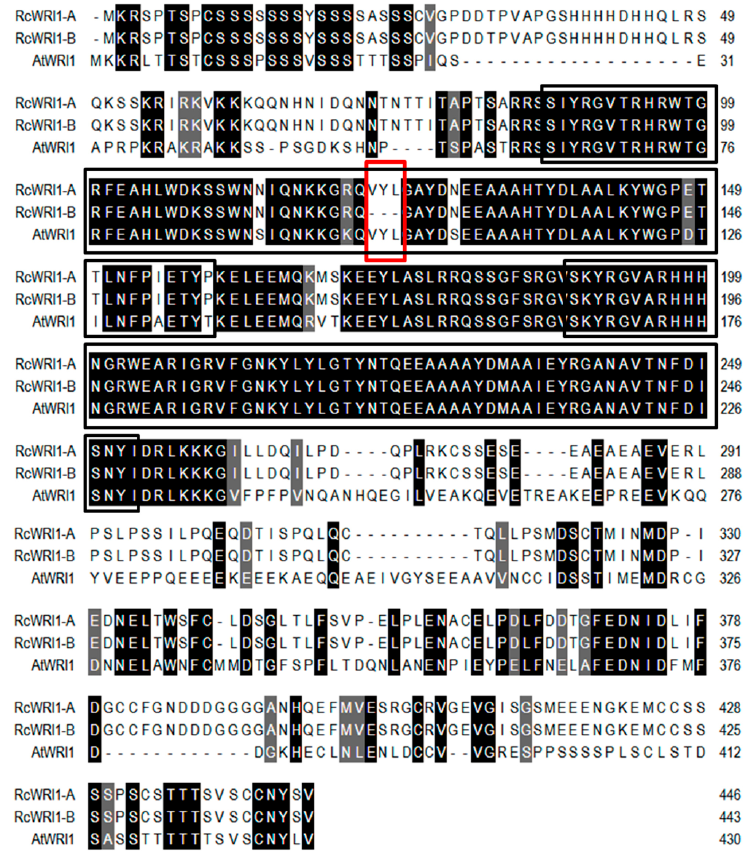
Figure 1. Sequence alignment of two RcWRI1 and AtWRI1 protein isoforms. The alignment was performed by the ClustalW program. Most of the difference between protein sequences of RcWRI1s and AtWRI1 occurs at the C-terminal half of the protein. “VYL” motif in AtWRI1 and RcWRI1-A is absent in RcWRI1-B. The high and low consensus amino acid residues are denoted by black and gray colors, respectively. Two AP2 domains are marked by black boxes. The sequence “VYL” present in the first AP2 domain are marked by red box.